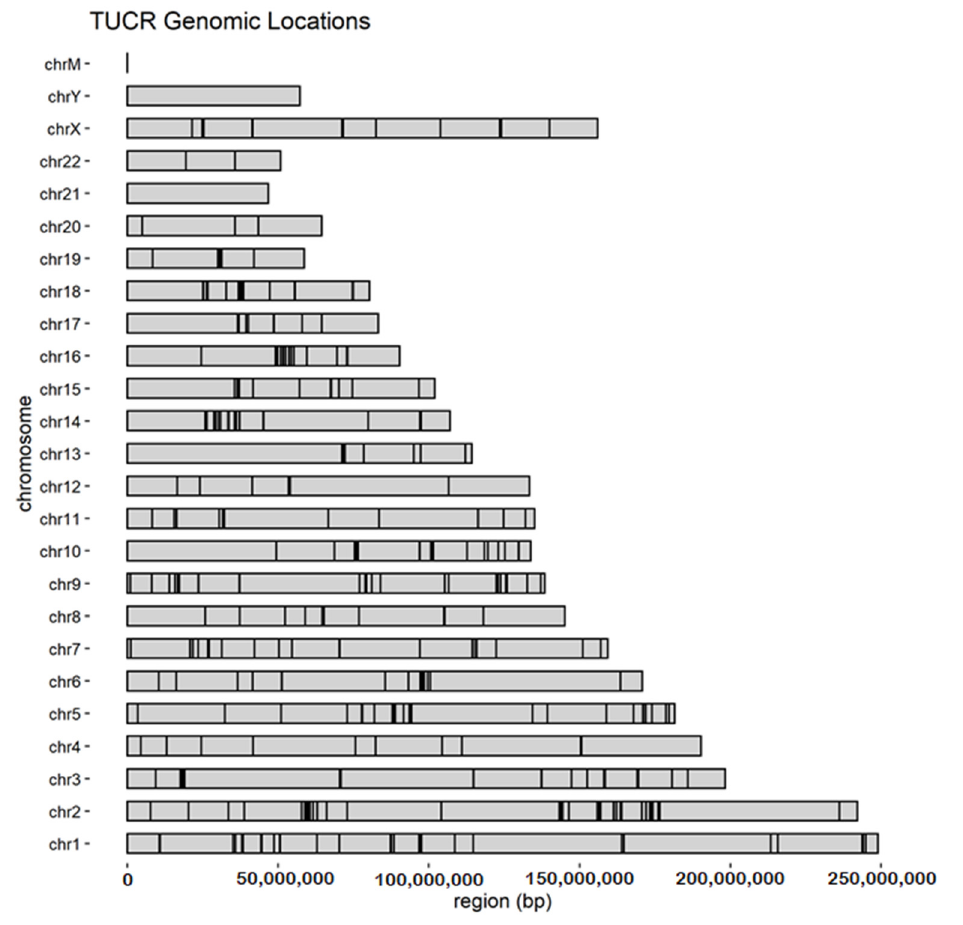
Figure 2. TUCRs are found on all number chromosomes and the X chromosome. TUCR locations are marked with a black vertical line showing their relative position on the chromosome. bp = base pair. Table 1. TUCRs are an understudied class of molecules. A PubMed search for the term “cancer” and “TUCR” or “ultraconserved” in manuscript abstracts reveals that they are understudied compared to lncRNAs, enhancer RNAs, antisense RNAs, miRNAs, and